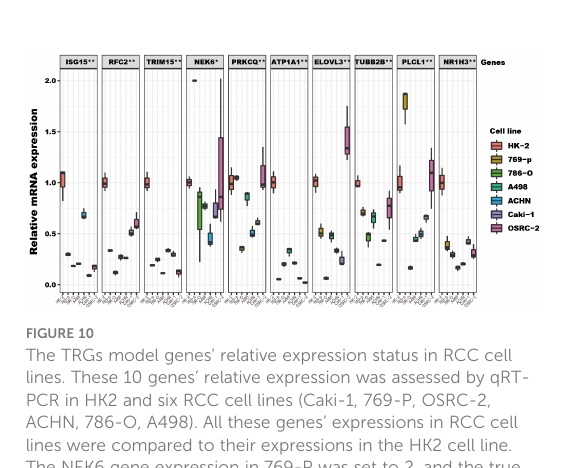
FIGURE 10 The TRGs model genes ’ relative expression status in RCC cell lines. These 10 genes ’ relative expression was assessed by qRT- PCR in HK2 and six RCC cell lines (Caki-1, 769-P, OSRC-2, ACHN, 786-O, A498). All these genes ’ expressions in RCC cell lines were compared to their expressions in the HK2 cell line. The NEK6 gene expression in 769-P was set to 2, and the true value was more than 2 (Supplementary File). The headline of this fi gure represents the TRGs model genes name. (*represents p<0.01, **represents